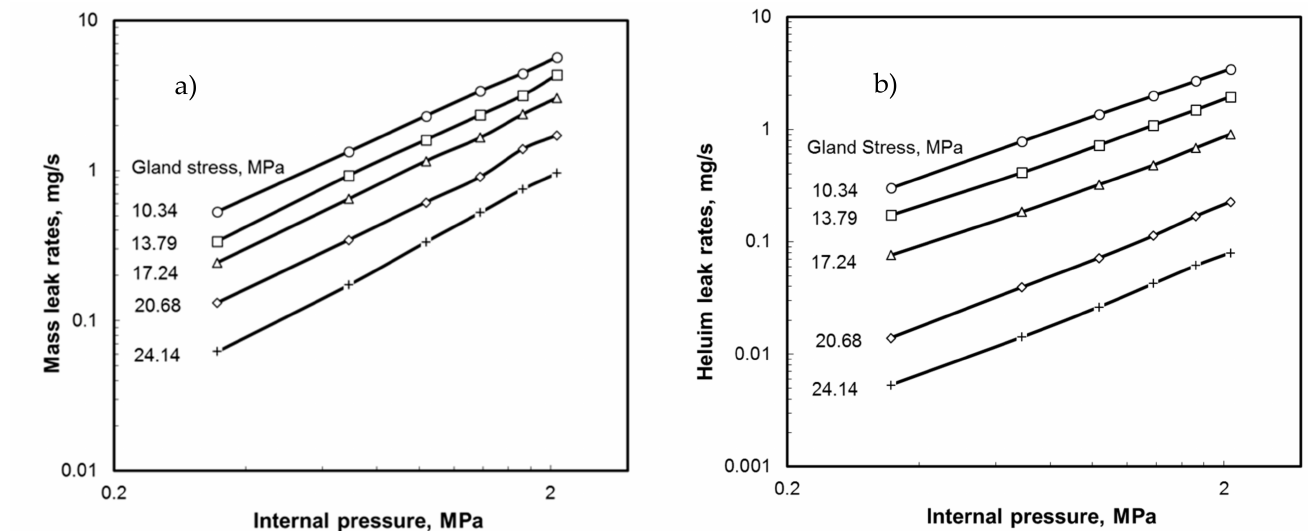
Figure 4. Helium leak tests ( a ) Flexible graphite, ( b ) die ring.